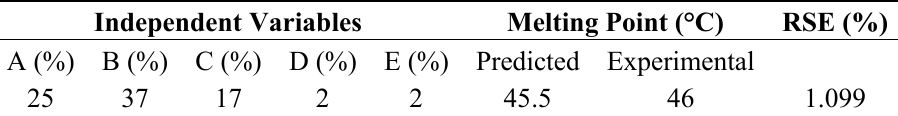
Table 4. Predicted and observed values for optimal